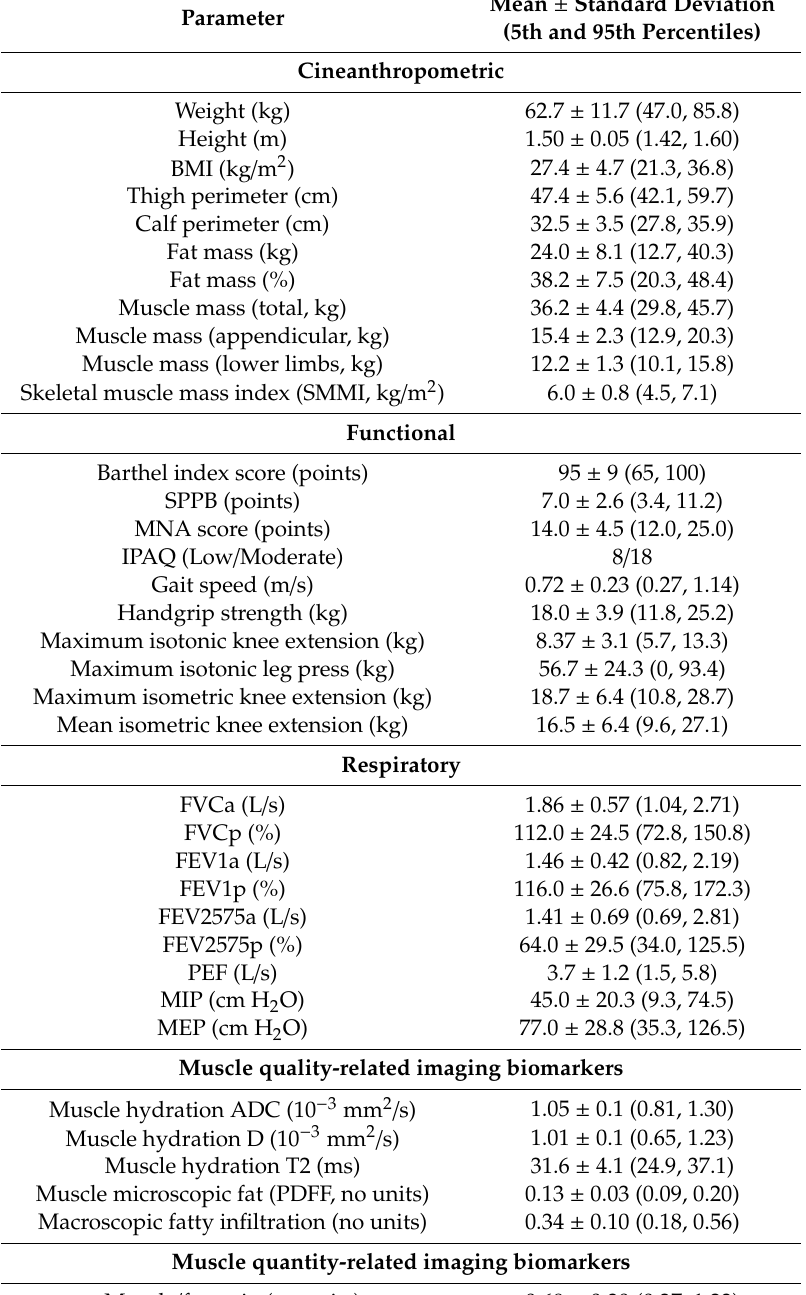
Table 2. Cineanthropometric, functional, respiratory, and image parameter characterization of the studied